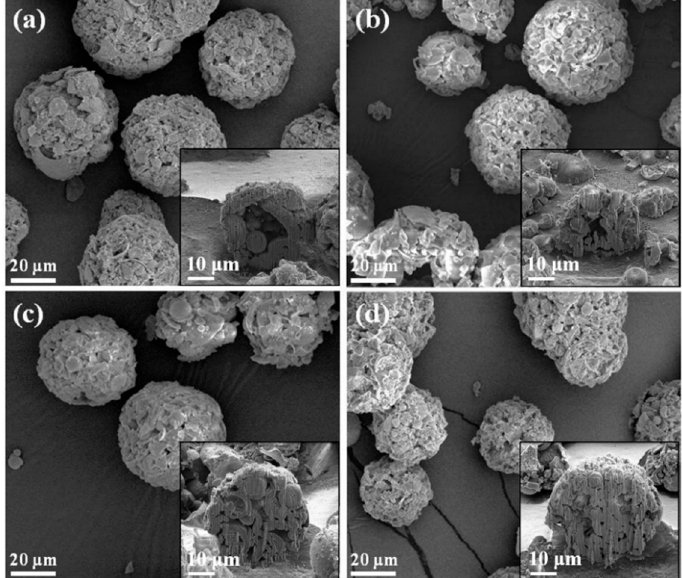
Figure 1. SEM images of BG microspheres treated with ( a ) 0, ( b ) 5, ( c ) 10 and ( d ) 20 wt.% PMMA, with insets of their cross-sectional images.